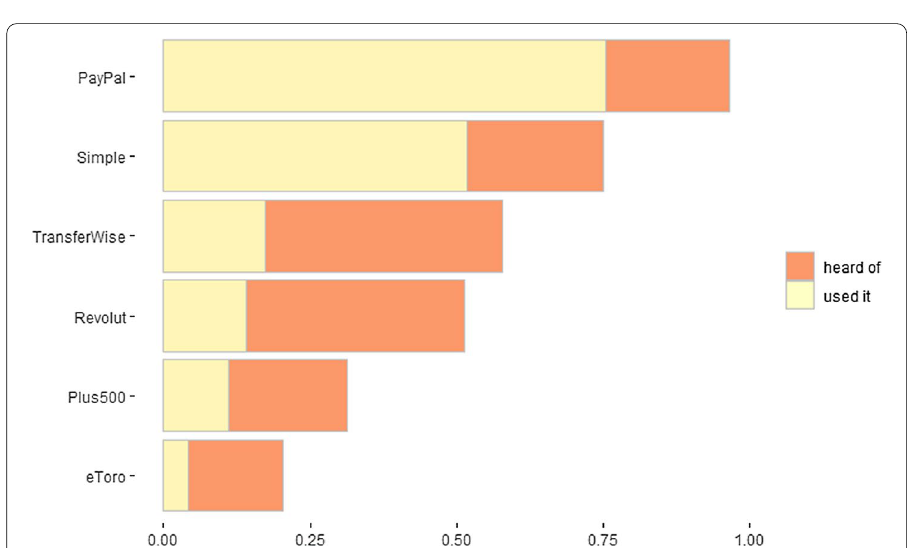
Fig. 6 How familiar respondents are with novel financial (fintech)